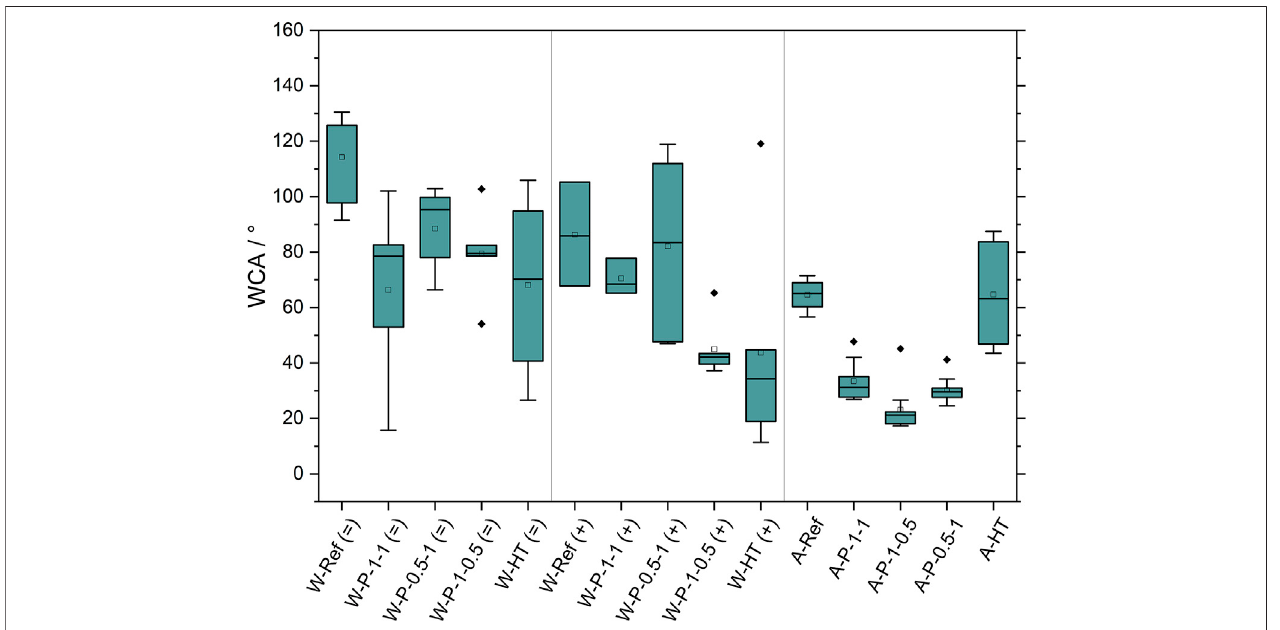
FIGURE 2 | Water contact angle (WCA) results for different sample systems denominated by Material (Wood; Aluminum) — Treatment (Untreated Reference; Plasma; Homogeneity Test) — Gap distance in mm — Forwarding speed in mm/s, and observation direction ( (cid:1) ) parallel to the grain or (+) perpendicular to the grain,